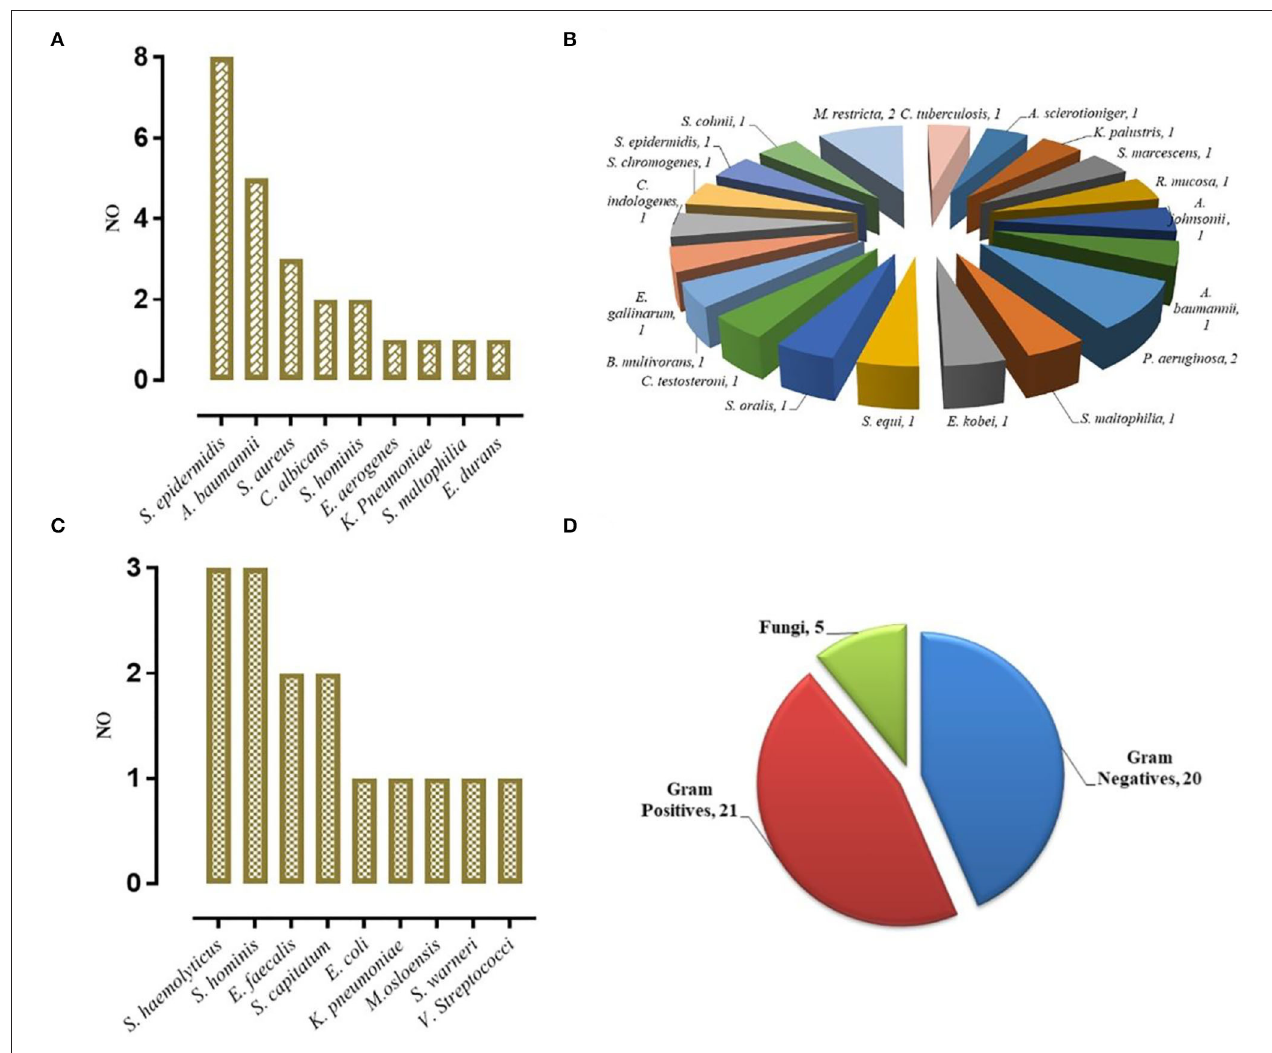
FIGURE 2 | VM Diagnosed by mNGS. (A) Concurrent diagnosis by mNGS and conventional microbiological testing (24). (B) Diagnosis by mNGS only (22). (C) Diagnosis by conventional testing only (15). (D) The category of pathogens diagnosed by mNGS.